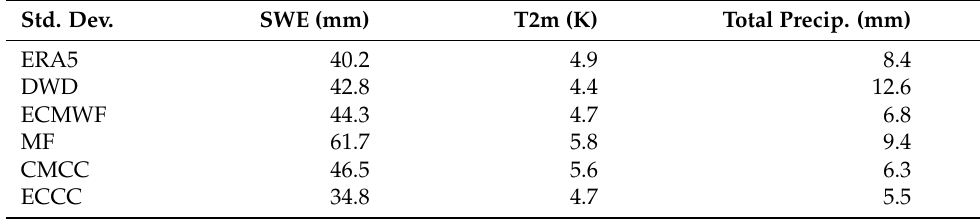
Table 2. Inter-annual variability (standard deviation) for March (forecasted from February) of total snow water equivalent (SWE), monthly mean 2-m temperature (T2m), and monthly total precipitation over Siberia from 1993 to 2016 for the seasonal forecasting systems. Variabilities for March from ERA5 are also